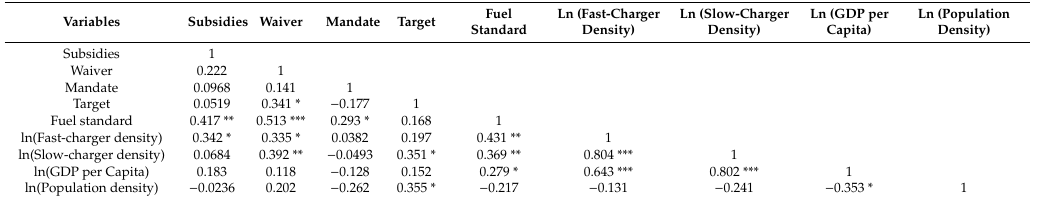
Table 5. Correlation coefficients of variables.